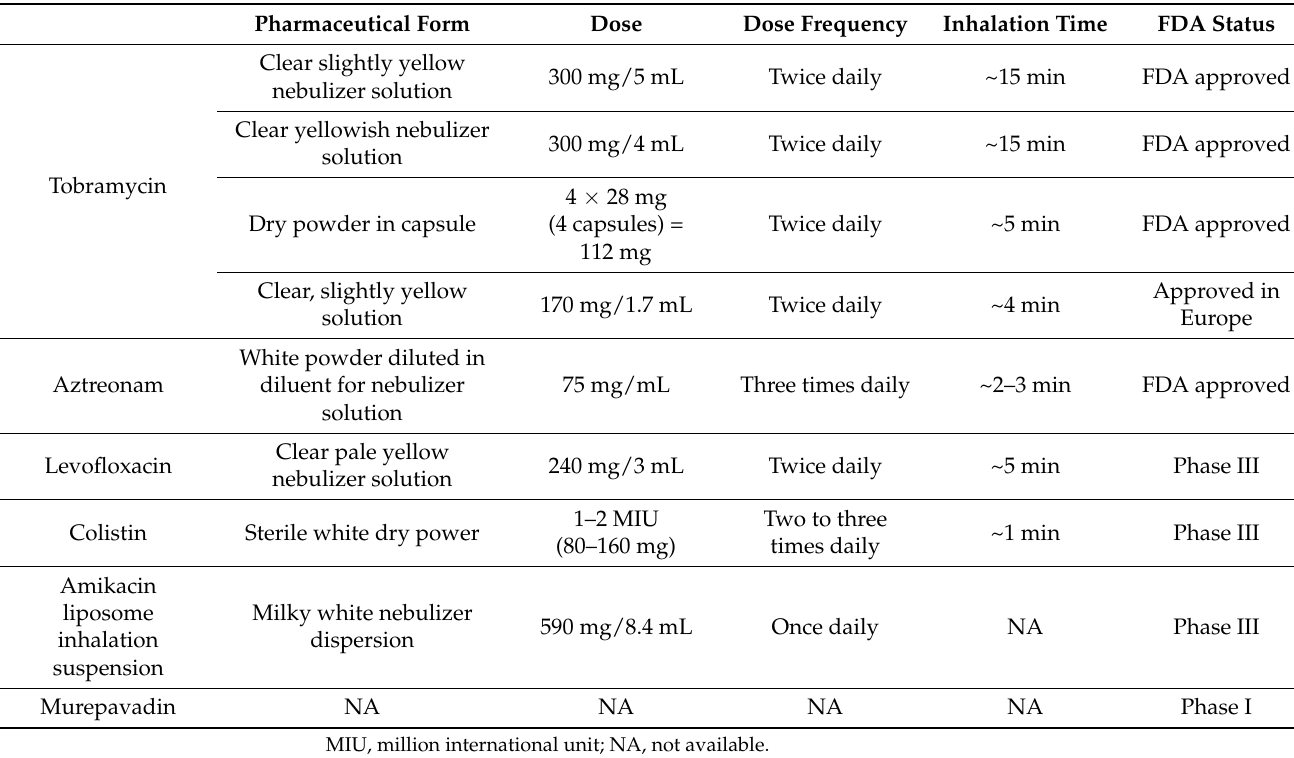
Table 1. Summary of Inhaled Antibiotics to Treat Chronic P. aeruginosa Pulmonary Infections in CF Patients.